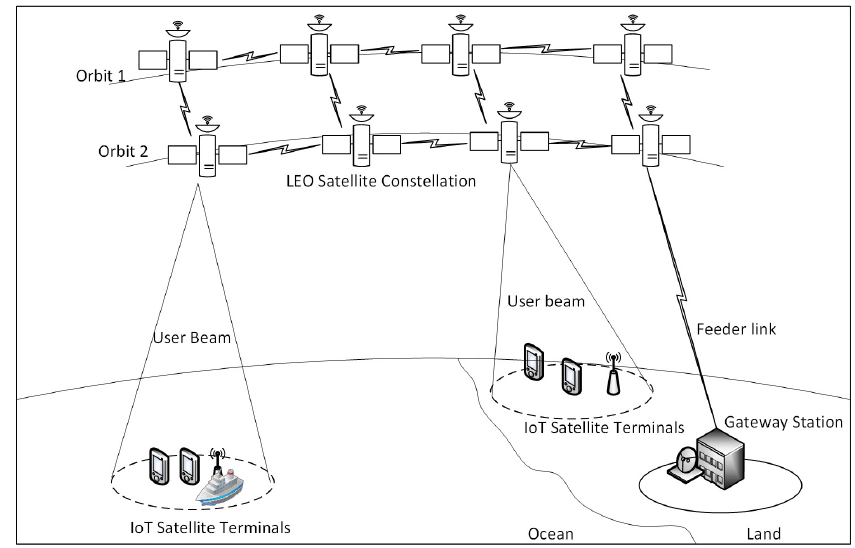
Figure 1. The satellite–terrestrial integrated Internet of Things